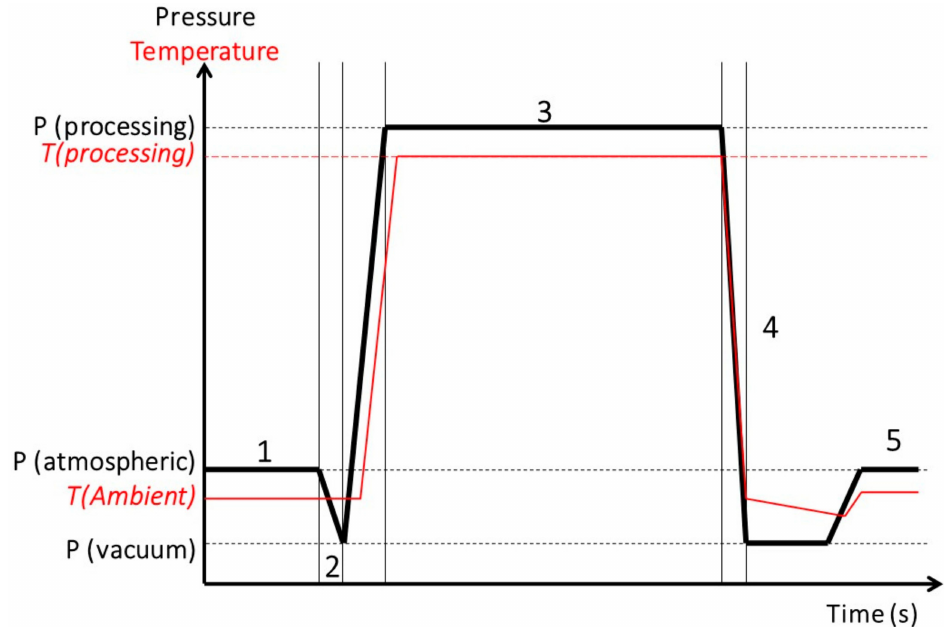
Figure 2. Typical pressure/temperature-time profile for a DIC processing cycle: (1) introduction of food material to the reactor; (2) establishment of an initial vacuum in the processing reactor; (3) injection of dry saturated steam until achieving and retaining a previous target pressure during a selected treatment time; (4) instant controlled pressure-drop towards a vacuum, and (5) releasing to atmospheric